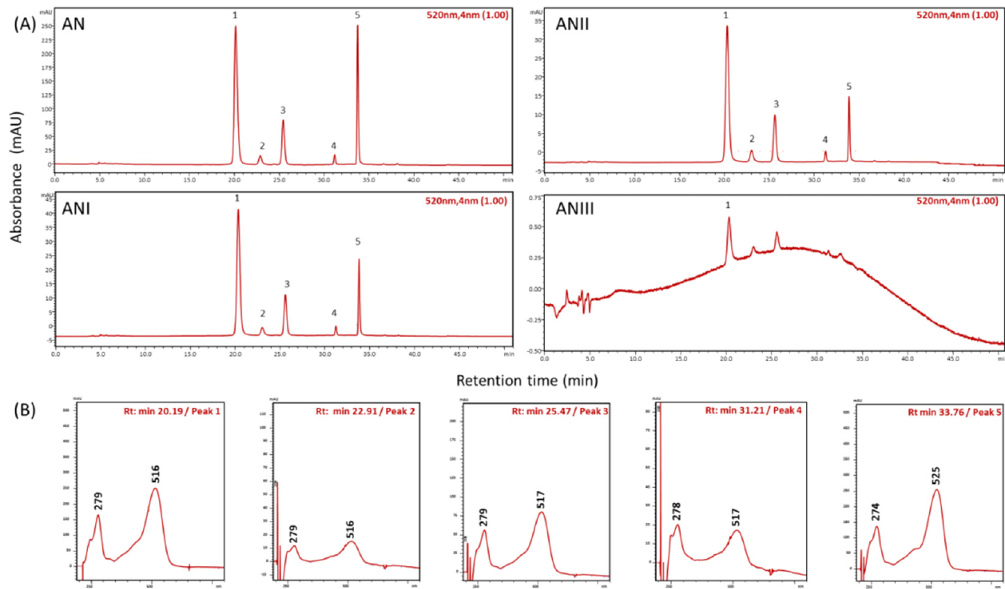
Figure 2. Identification of each anthocyanin from the purified chokeberry extract (AN) and chromatograms recorded in different steps of the CaCO 3 (PAH)@RBITC@AN synthesis (ANI, ANII, ANIII). Identified peaks of chromatograms ( A ): peak1 Cyanidin-3-galactoside; peak2 Cyanidin-3-glucoside; peak3 Cyanidin-3-arabinoside; peak4 Cyanidin-3-xyloside; peak5 Cyanidin and their spectral UV-Vis characteristics ( B ).